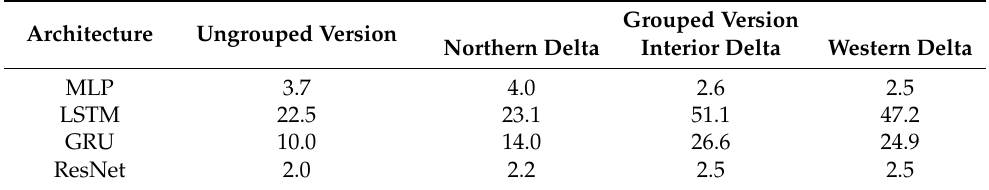
Table A8. Total training time (in minutes) of each architecture proposed, including ungrouped version (one model for 28 stations) and grouped version (three models, one for each station group).